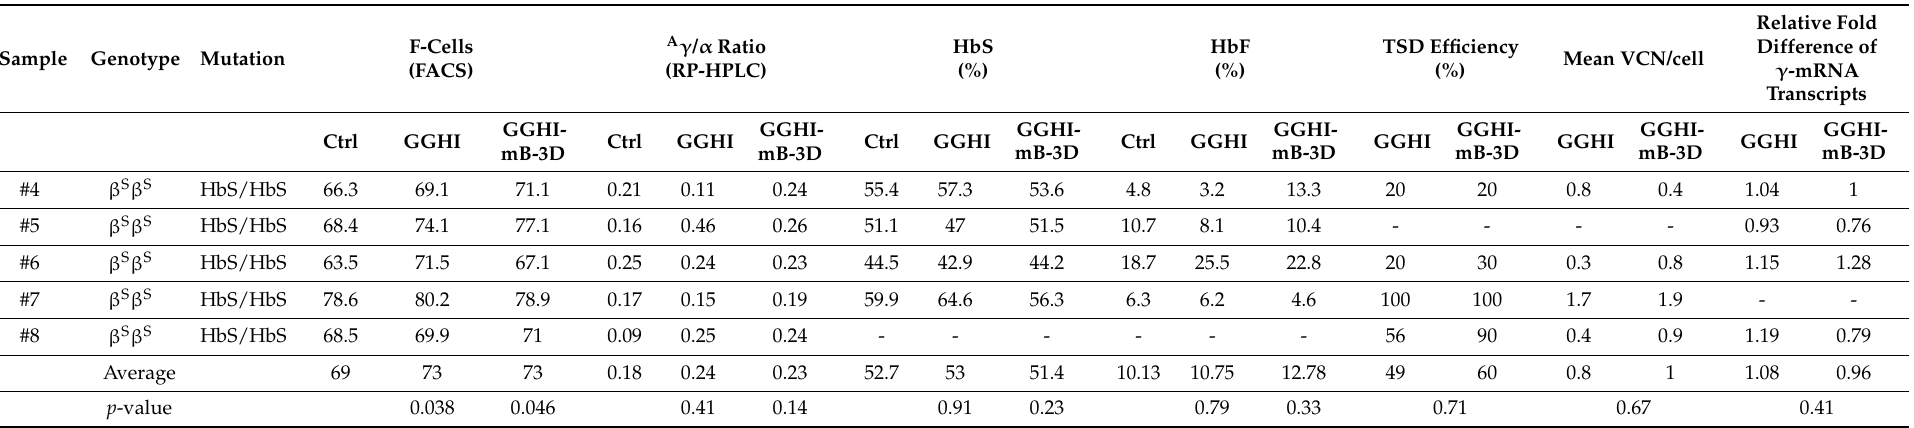
Table 2. Detailed results from β S β S